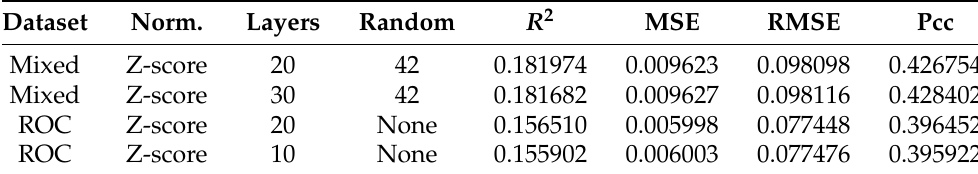
Table 6. Top 2 best metric performers in DWNN regressor.